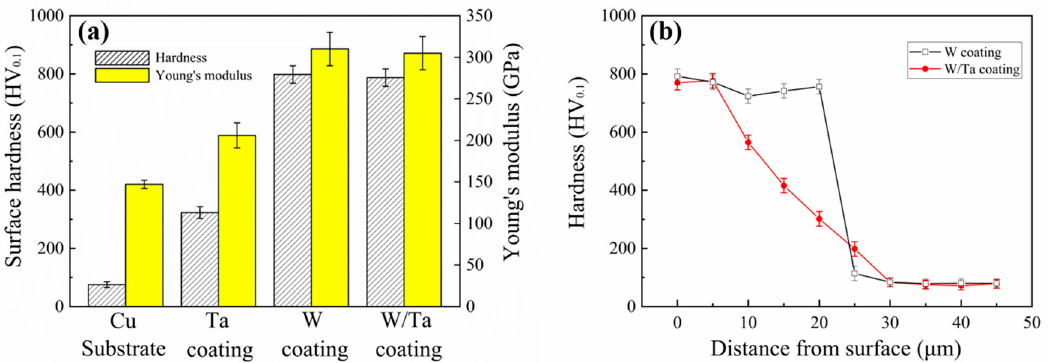
Figure 5. Mechanical properties of different specimens: ( a ) surface hardness and Young’s modulus and ( b ) cross-sectional hardness of the W coating and W/Ta coating.